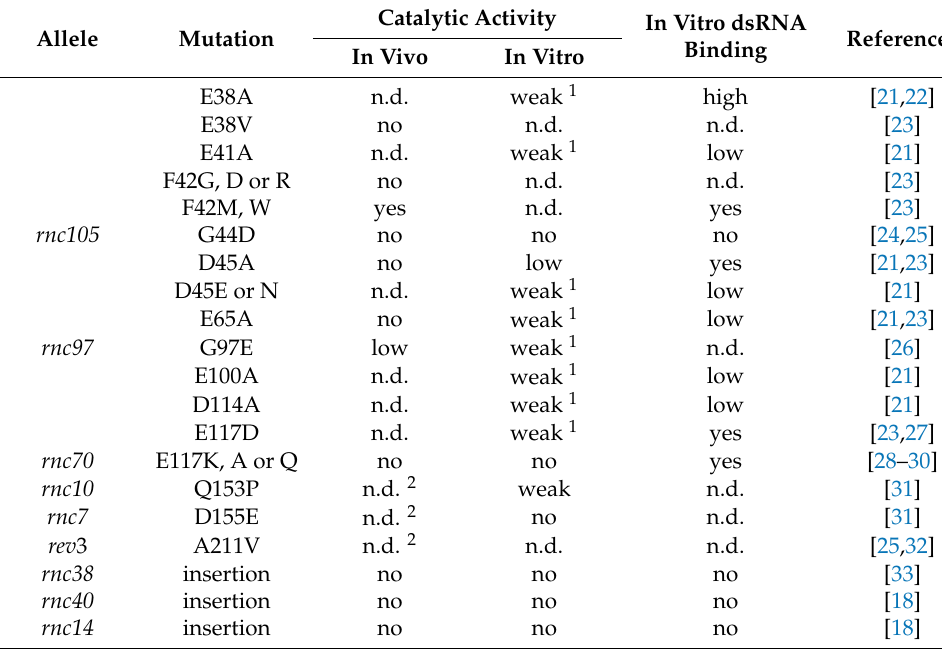
Mutations are either missense, indicated by the amino acid, its number relative to the sequence of Ec-RNase III followed by the replacing amino acid(s) or insertions of fragments derived from transposons and plasmids. 1 In excess of magnesium. 2 Suppressors of cold-sensitive mutant alleles. n.d. not